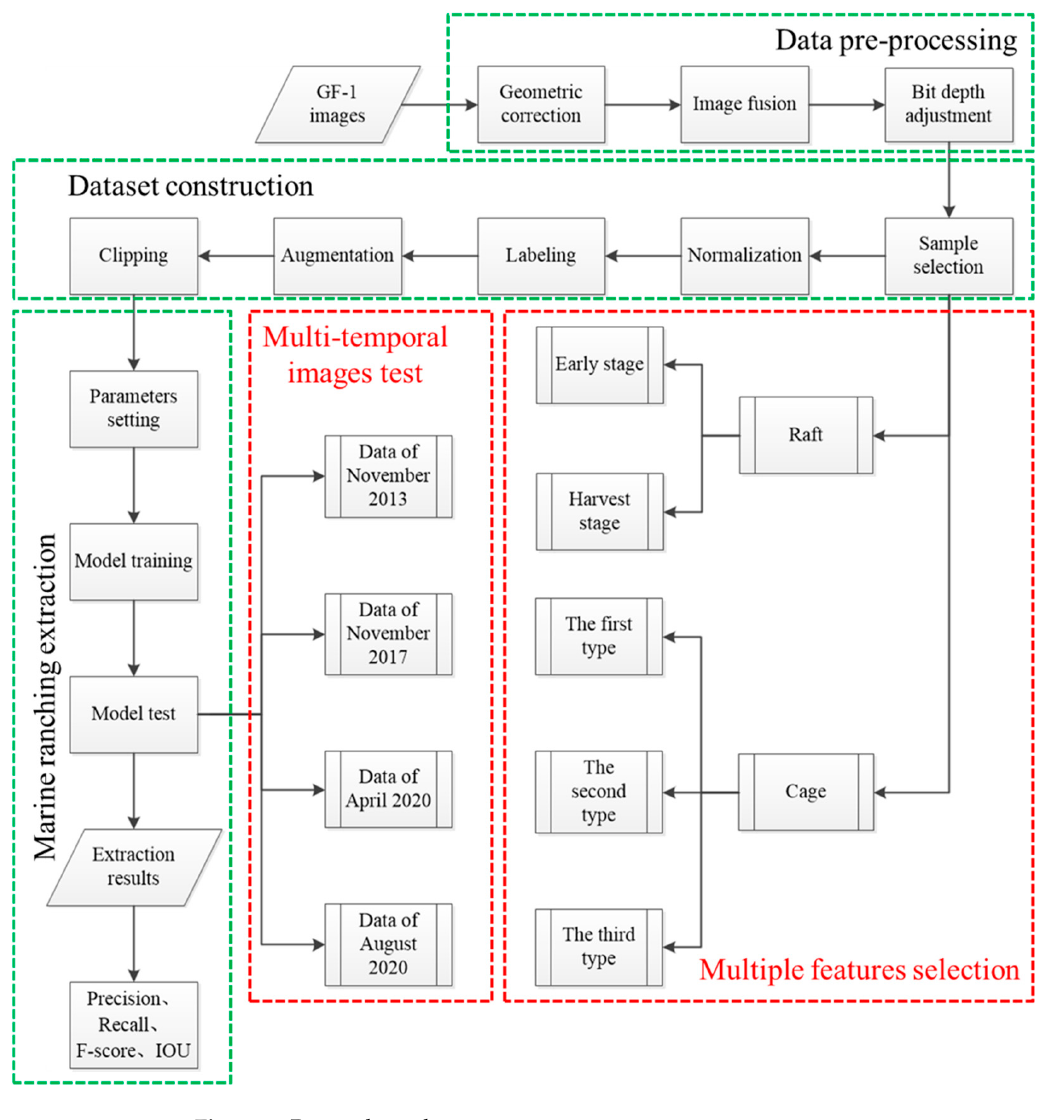
Figure 1. Research roadmap.